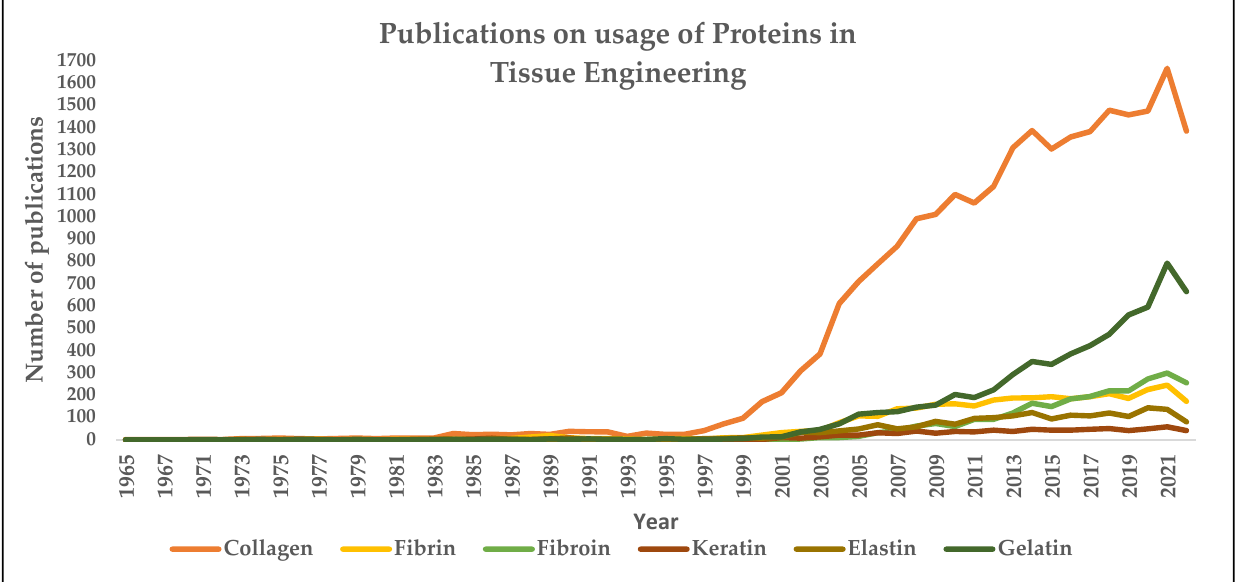
Figure 8. Publications on the usage of polysaccharides in tissue engineering. (The number of papers published on individual polysaccharides such as cellulose, chitin, alginate, starch, hyaluronic acid, and pullulan is drawn based on the year and the respective total number of papers published, using search engine: www.scopus.com.)